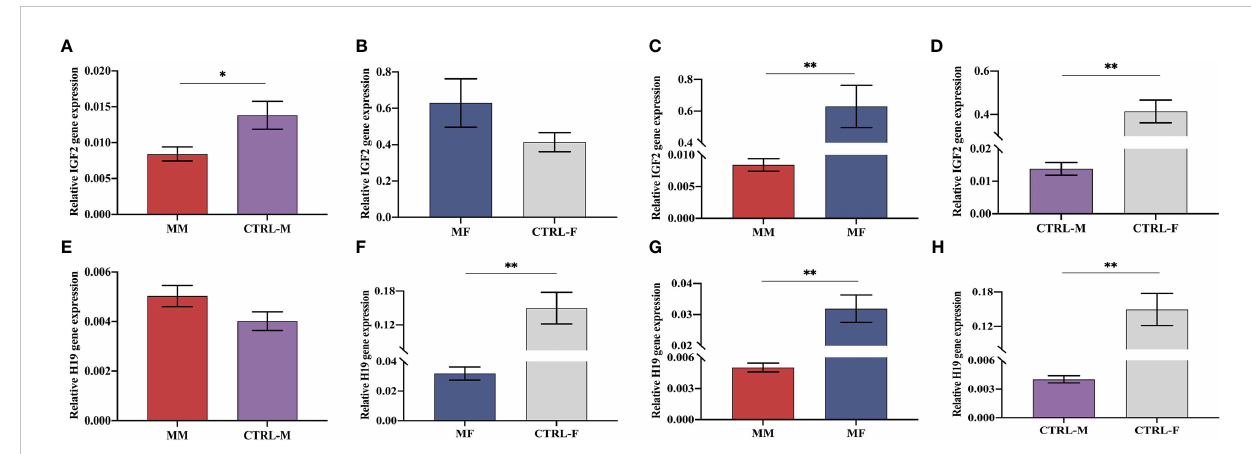
FIGURE 5 Expression levels of IGF2 mRNA (A – D) and H19 RNA (E – H) in maternal peripheral blood and the corresponding fetal cord blood of the macrosomia group (MM, MF) and normal birth weight group (CTRL-M, CTRL-F). * P < 0.05; ** P < 0.01.